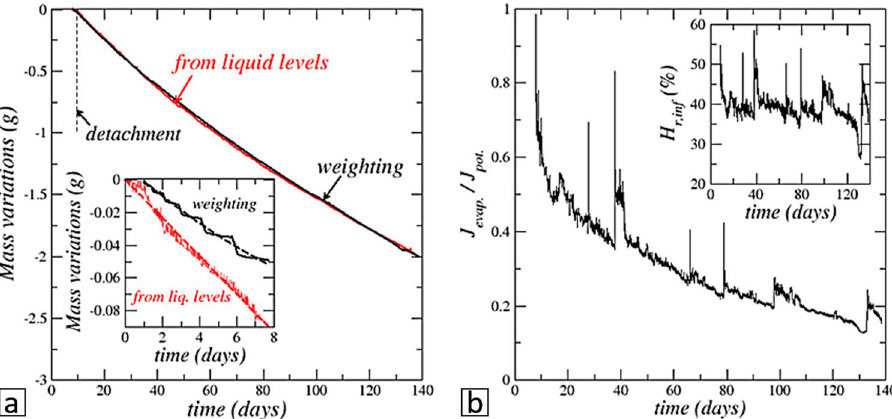
Figure 3. ( a ) Mass variations as a function of time after crust detachment. Comparison between the mass variation measured by weighting (dark solid line) and the one computed from the liquid level variations (red solid line) in the cell and adjacent cylinder. The inset shows the mass variations in the period before detachment (dashed lines are fits showing the main trends). ( b ) Comparison between the measured evaporation rate in the cell and the potential evaporation rate. The inset shows the relative humidity variation at the cell